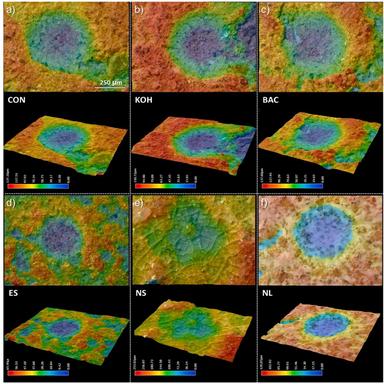
3D microscopy and surface roughness analysis of indentation marks on the earthen mock-ups. a) Untreated sample (CON), b) alkaline activation treatment (KOH), c) bacterial treatment (BAC), d) ethyl silicate treatment (ES), e) nanosilica treatment (NS), and f) nanolime treatment (NL). The upper and lower images of each panel show the 2D and 3D view of the depth heatmaps (scale bar = 250 µm), respectively.